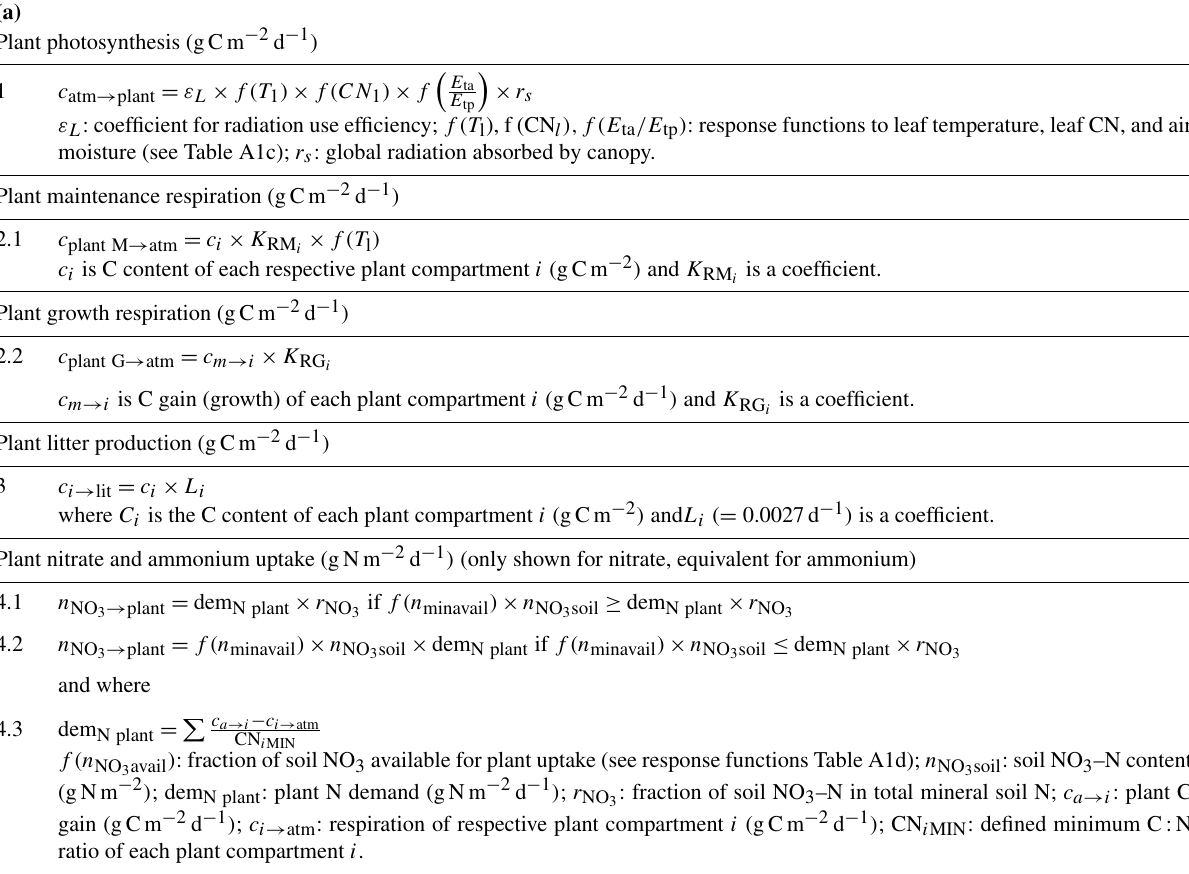
Table A1. Model functions describing plant growth, ECM fungal growth, model parameters, and response functions of plant and ECM. Parameters are always shown with capital letters. (a) Description of plant model functions. ( i is fine roots, coarse roots, stem, leaves, grain, mobile). (b) Functions describing processes related to ECM fungal growth and N exchange to plant. (c) Overview of response functions of plant and ECM fungal growth and N uptake. (d) Overview of model parameters; previous CoupModel parameters are mostly from Svensson et al. (2008a) and ECM parameters are from literature values (Meyer et al., 2012, and references therein). No.